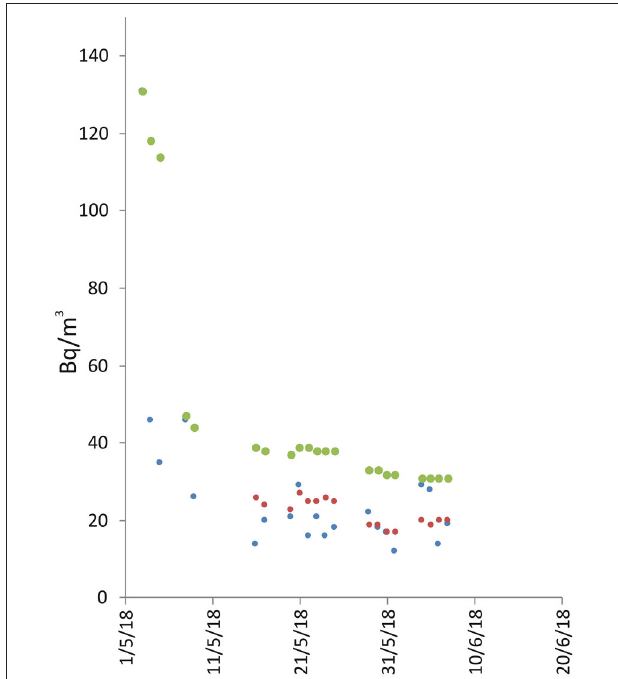
FIGURE 5 | Radon measurements recorded in the Zafferana Etnea territory, at location 6 (see Figure 1 , sensor 10). Radon concentration are presented as daily (blue line), weekly (red), and long-term (green) averages. The discontinuities of the green line (long-term average) indicate only discontinuity in the data